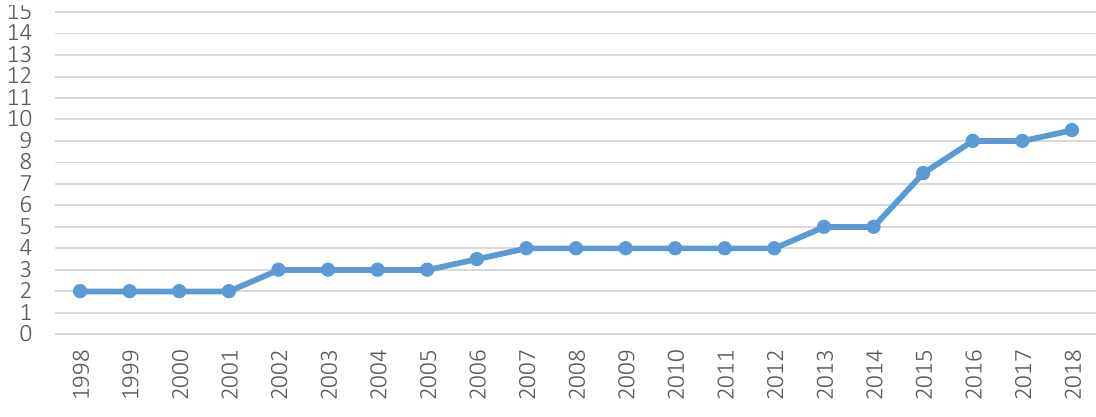
Figure 3. Central bank transparency index for Ukraine,